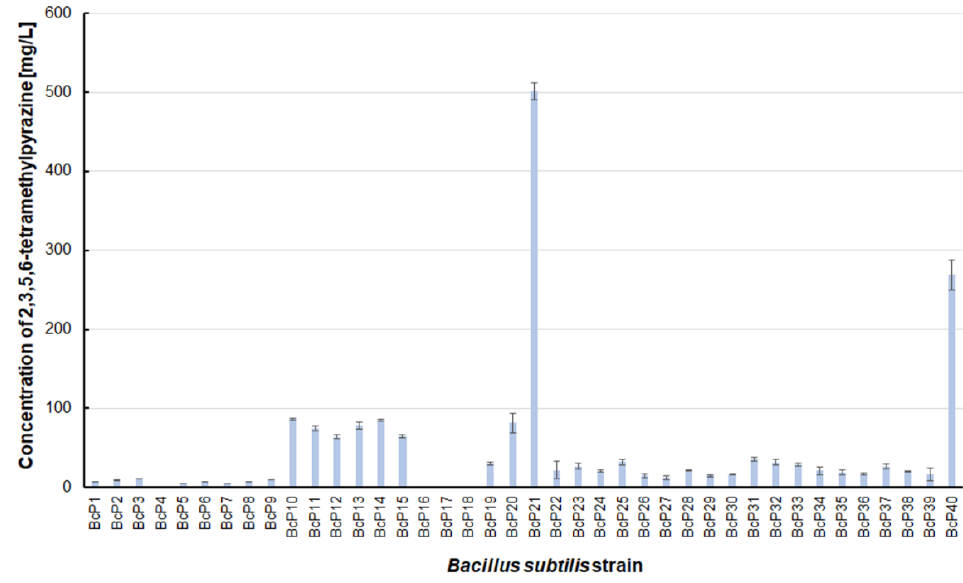
Figure 7. The 2,3,5-trimethylpyrazine biosynthesis by B. subtilis strains.